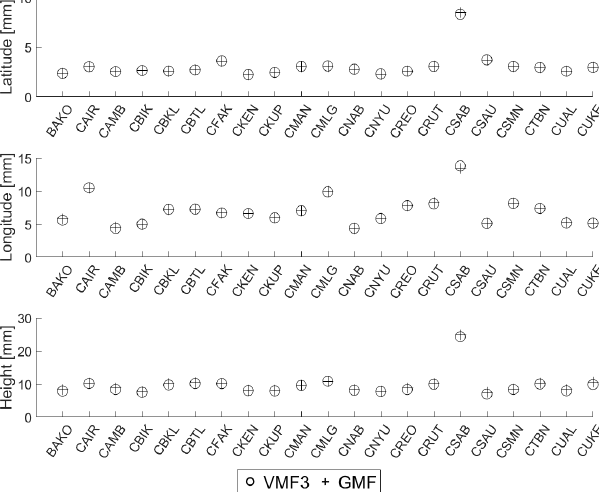
Figure 4. Repeatability of estimated coordinates from VMF3 and